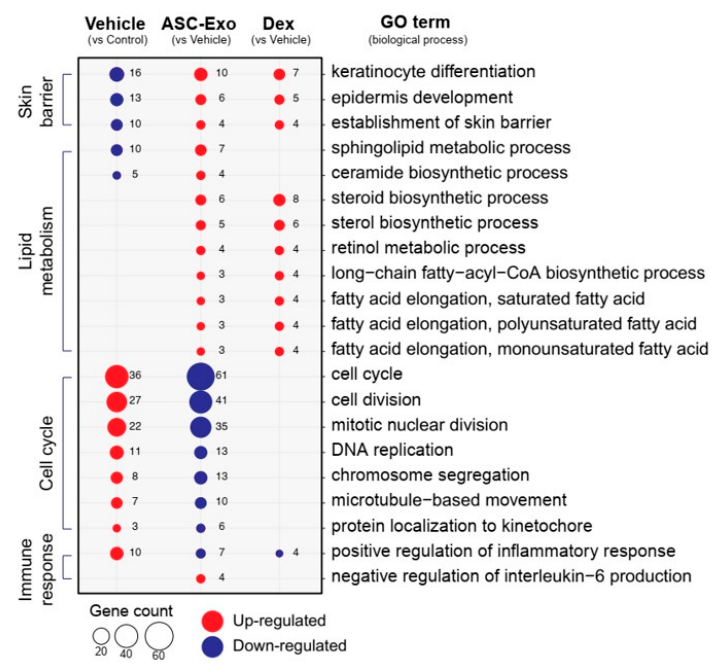
Figure 8. ASC-exosomes normalize altered gene expression in a murine model of allergic dermatitis. Bubble plot shows the significantly ( p < 0.05) altered GO biological processes in vehicle, ASC-exosomes-, and dexamethasone-treated groups compared with the indicated control group. The size of the bubble is proportional to the number of genes. Red bubbles indicate up-regulation and blue bubbles denote down-regulation. GO analysis was performed using DAVID bioinformatics resources 6.8 (https://david.ncifcrf.gov).